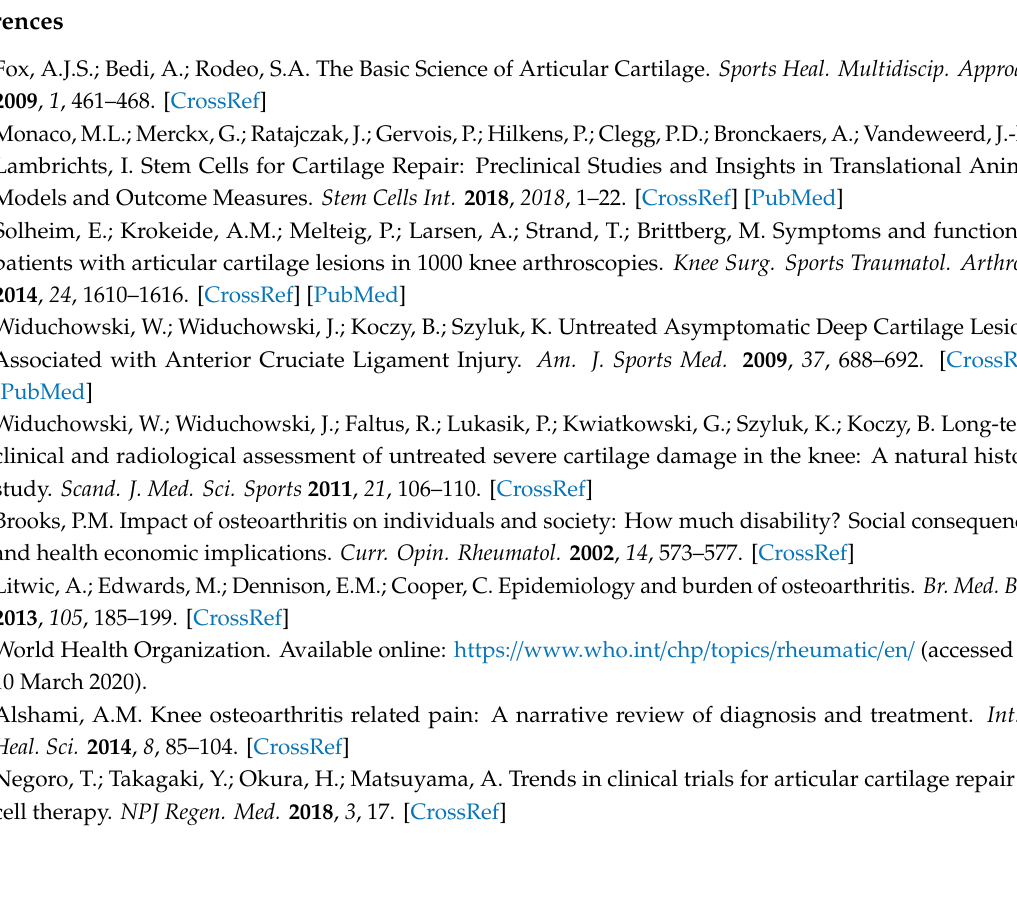
Supplementary Materials: The following are available online at http: // www.mdpi.com / 2073-4409 / 9 / 4 / 980 / s1, Supplementary Materials and Methods, Table S1: The Primers used for RT-qPCR analysis. Figure S1: The e ff ect of L-PRF ex, L-PRF CM and DPSC CM on chondrogenic genes of